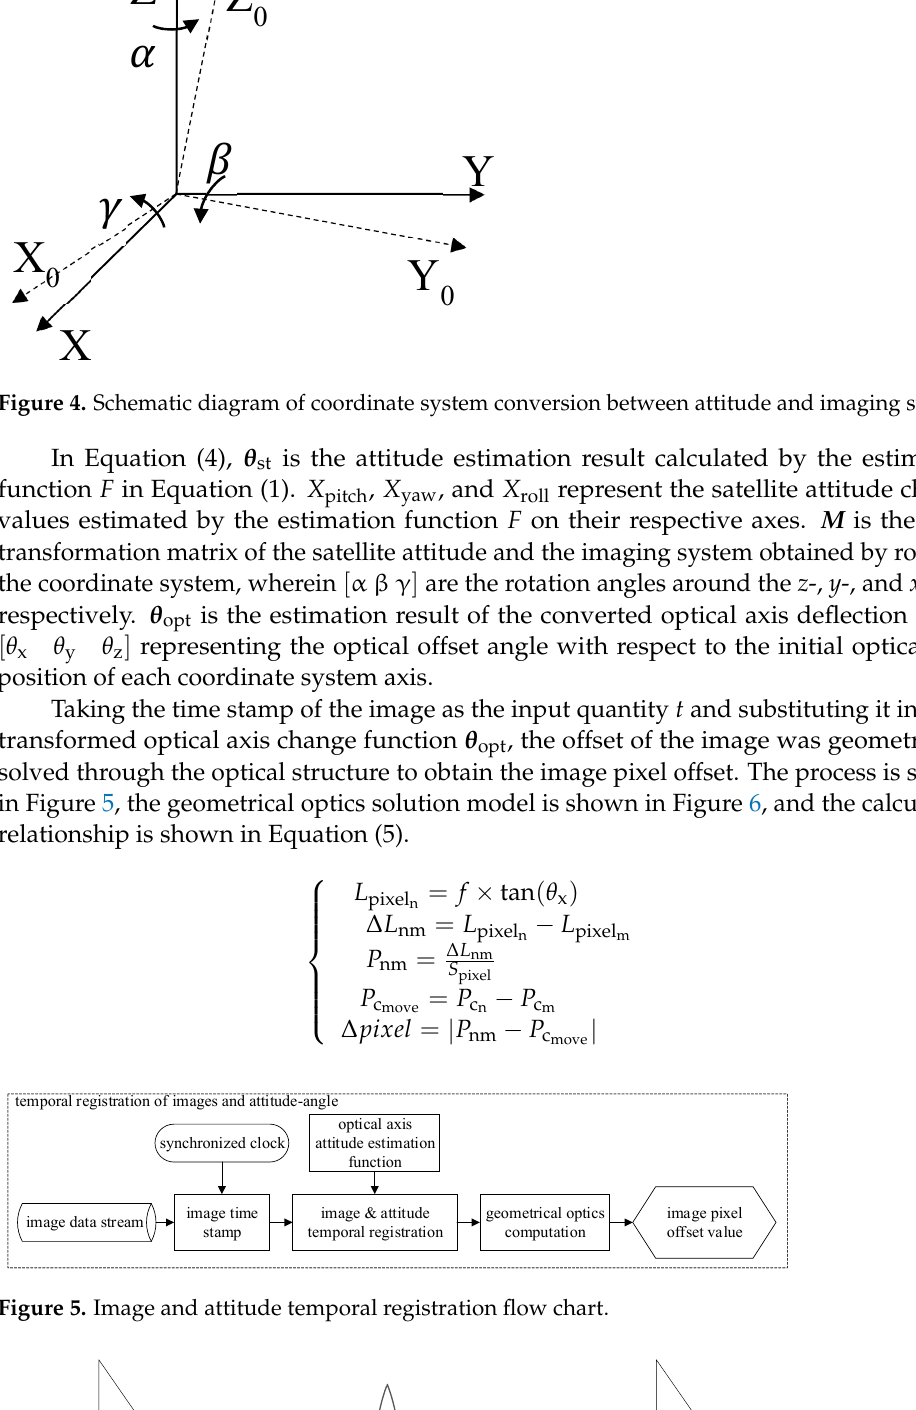
Figure 5. Image and attitude temporal registration flow chart.